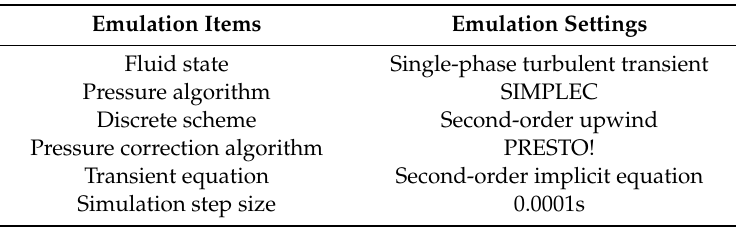
Table 2. Solution strategy.